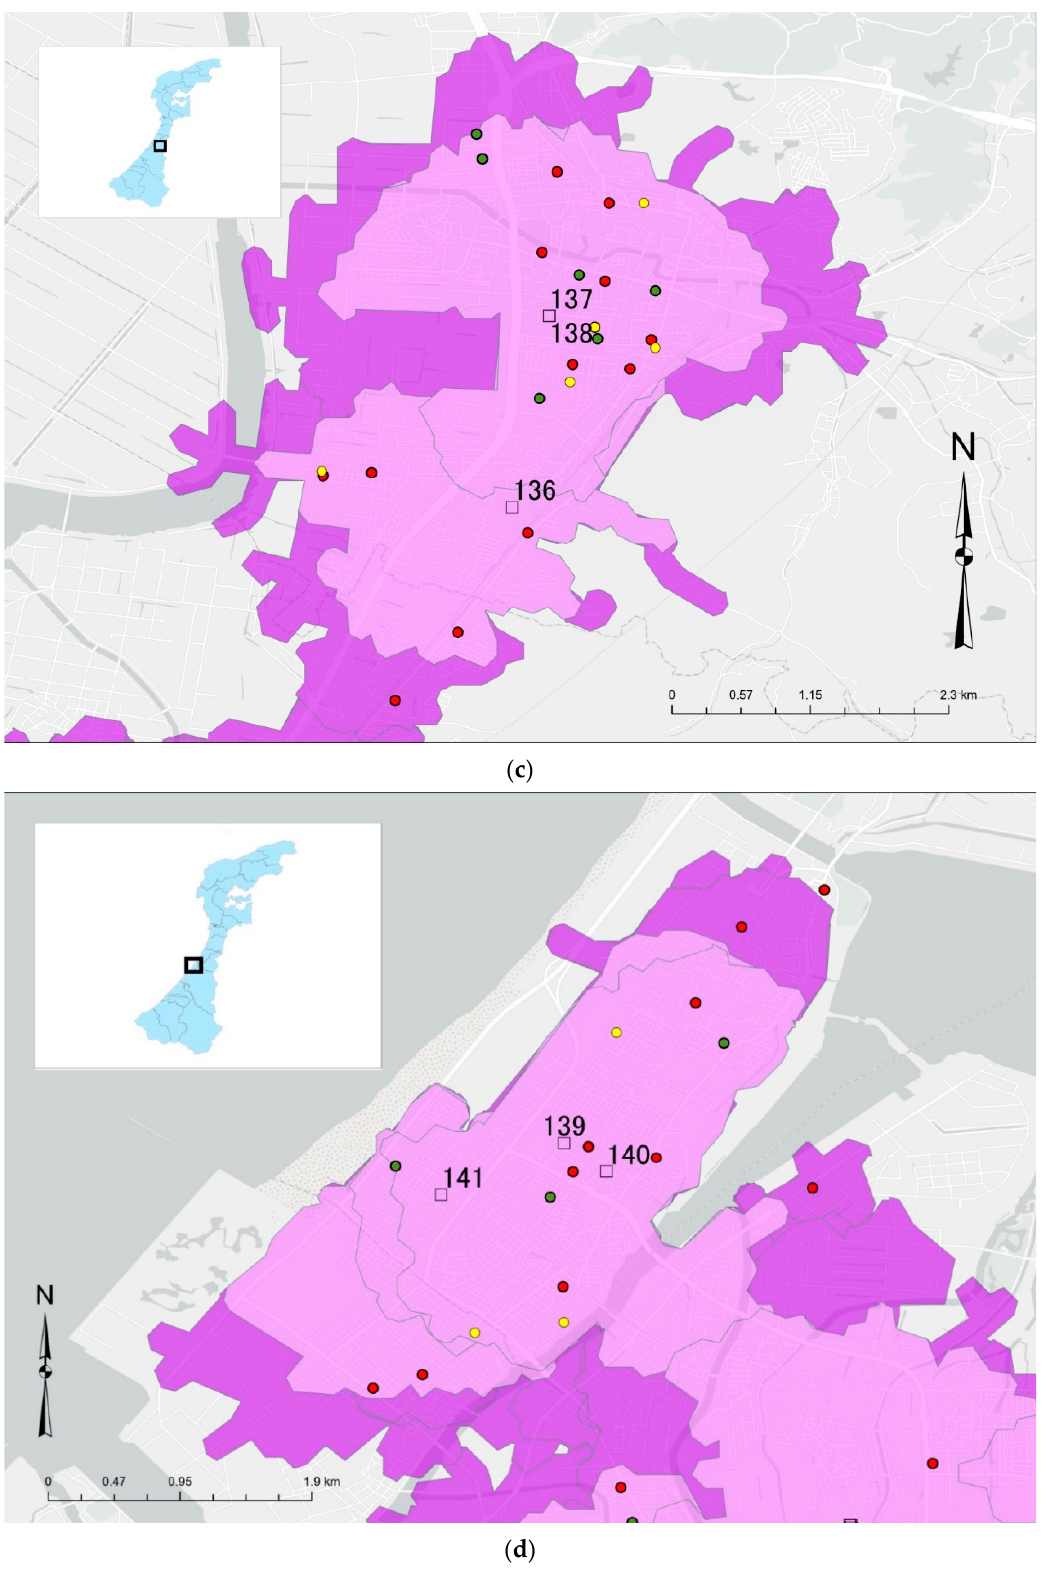
Figure 4. ( a ) Geographical distribution of GHs and SPs in ELAs in Houdatshushimizu Town. ( b ) Geographical distribution of GHs and SPs in ELAs in Kahoku City (For legends, see Figure 4a). ( c ) Geographical distribution of GHs and SPs in ELAs in Tsubata Town (For legends, see Figure 4a). ( d ) Geographical distribution of GHs and SPs in ELAs in Uchinada Town (For legends, see Figure 4a).